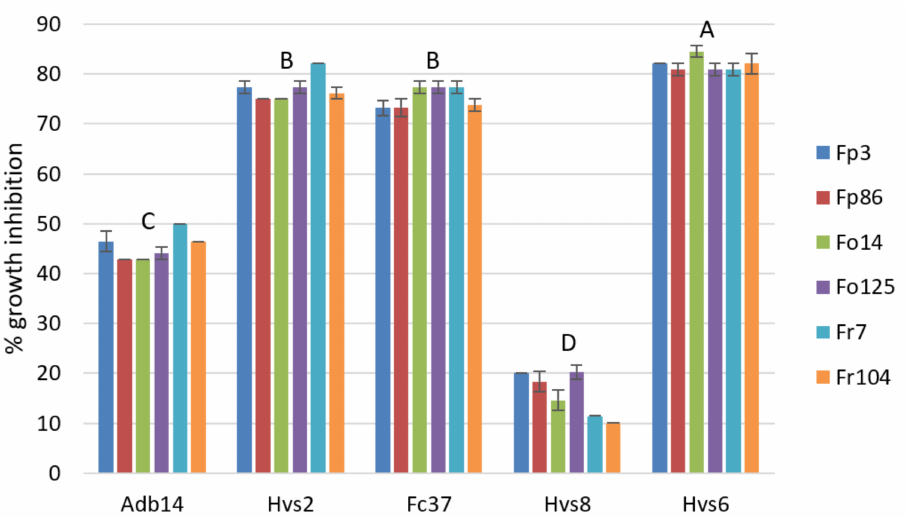
Figure 1. Percentage of mycelial growth inhibition of Fusarium proliferatum (Fp), F. oxysporum f sp. asparagi (Fo), and F. redolens (Fr) isolates by Bacillus amyloliquefaciens Adb14, B. paralicheniformis Hvs2, B. velezensis FC37, Brevibacterium frigoritolerans Hvs8, and Streptomyces fradiae Hvs6 bacterial strains. Results are the mean of three replicates and error bars correspond to the standard error calculated as the quotient of the standard deviation and the square root of the number of samples analyzed. Different letters indicate significant differences among bacterial strains based on the LSD test at p ≤